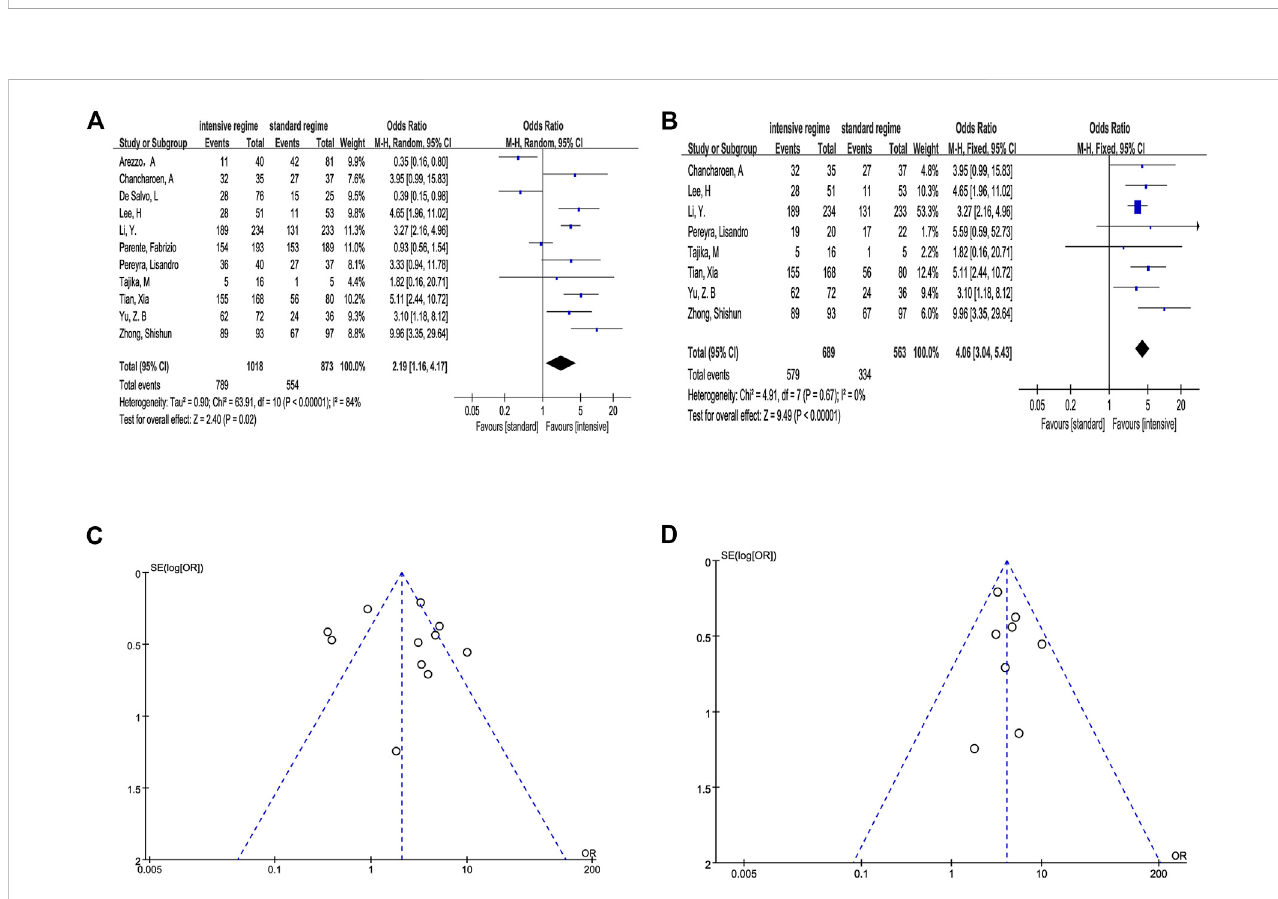
FIGURE 3 Outcomeofdirectmeta-analysis. (A,C) Forestgraphandfunnelgraphofintensiveregimenvs.standardregimen. (B,D) Forestgraphandfunnelgraphof intensive regimen vs. standard regimen based on the same